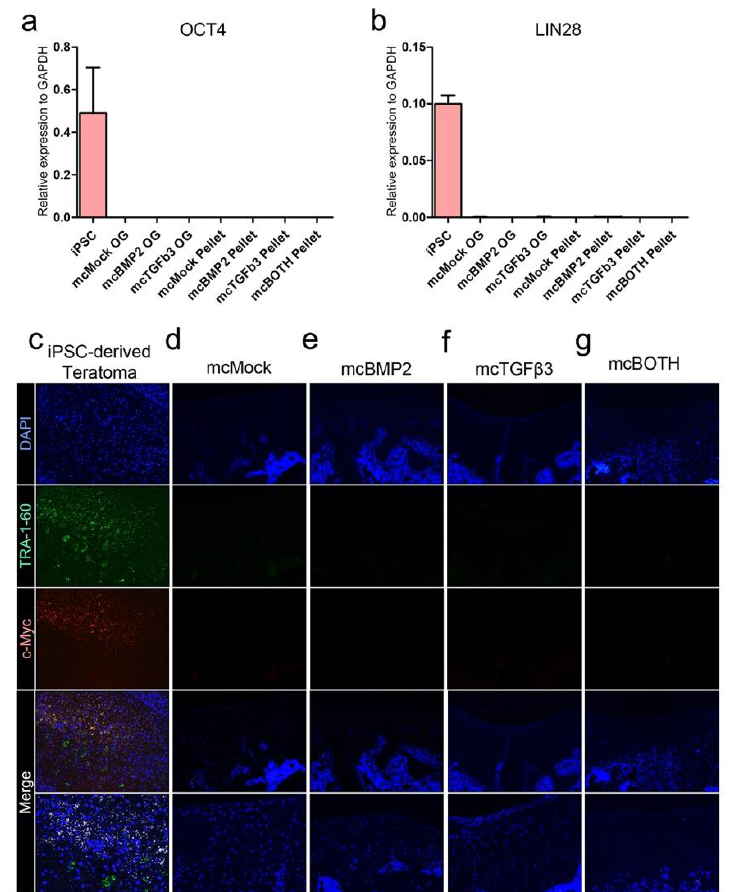
Figure 7. Confirmation of pluripotent markers in cells and tissue samples. ( a ) Relative gene expression of OCT4. ( b ) Relative gene expression of LIN28 in cells and pellets. ( c ) Fluorescence image of iPSC-derived teratoma tissues stained with the TRA-1-60 and c-Myc antibody. Fluorescence image of ( d ) mcMock, ( e ) mcBMP2, ( f ) mcTGF β 3, and ( g ) mcBOTH. Images show the 200 × magnification image. Scale bar represents 200 µ m. mcMock: minicircle mock vector-transfected outgrowth cells; mcBMP2: minicircle BMP2-encoding vector-transfected outgrowth cells; mcTGF β 3: minicircle TGF β 3-encoding vector-transfected outgrowth cells; mcBOTH: 1:1 mixture of mcBMP2- and mc TGF β 3-transfected outgrowth cells.